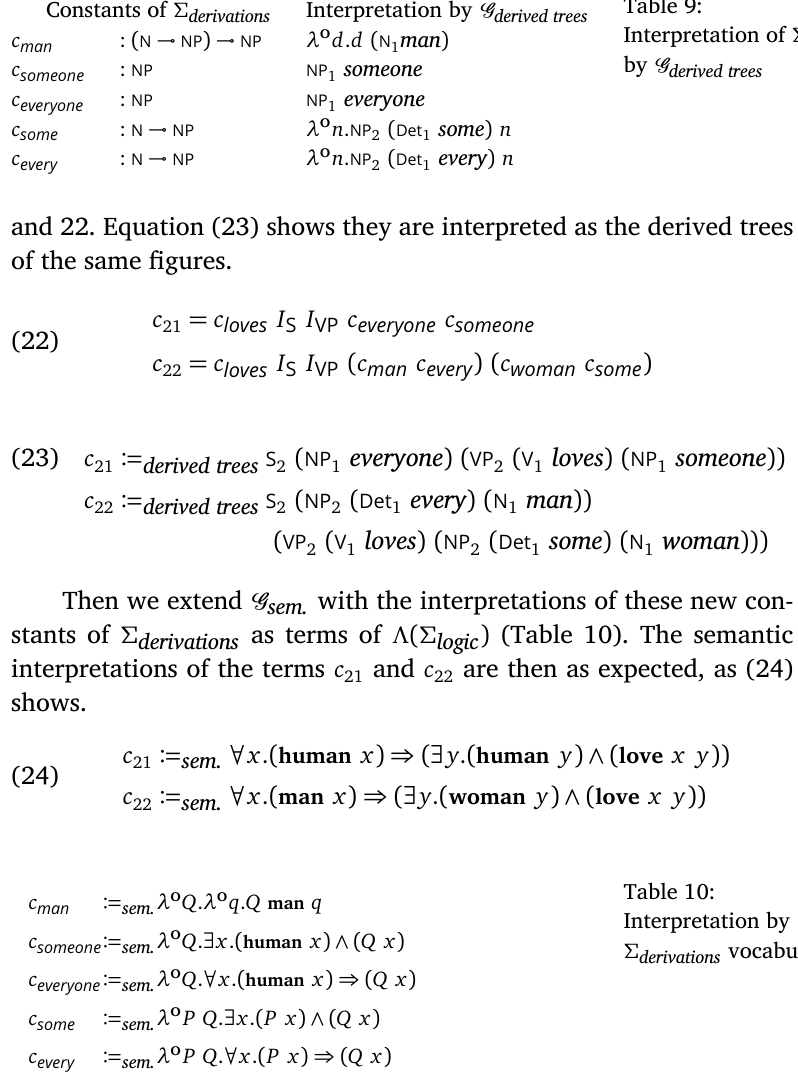
Interpretation by G sem. of the (cid:6) derivations vocabulary –